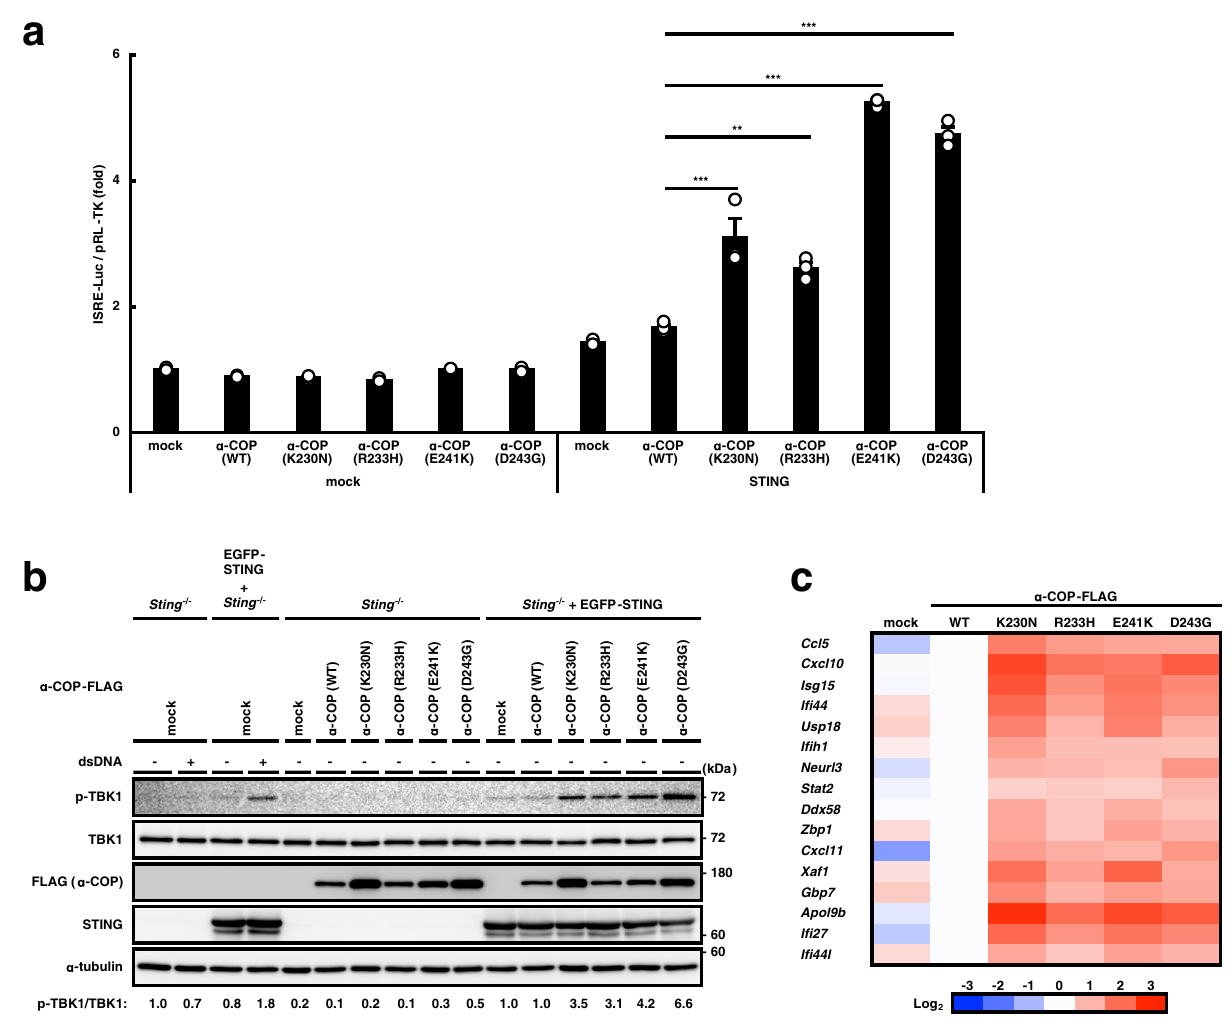
Fig. 1 The α -COP variants activate the STING pathway. a HEK293T cells were transfected as indicated, together with an ISRE (also known as PRDIII or IRF-E)-luciferase reporter. Luciferase activity was then measured. Data represent mean s.e.m. of three independent experiments. b STING and/or α -COP were stably expressed in Sting − / − MEFs. Cell lysates were prepared and analyzed by western blot. c Quantitative real-time PCR (qRT-PCR) of the expression of innate immune genes in MEFs expressing the α -COP variants. The indicated gene expression was normalized on the basis of GAPDH content and the log 2 fold change compared to α -COP (WT) was plotted as a heatmap. See also Supplementary Fig.